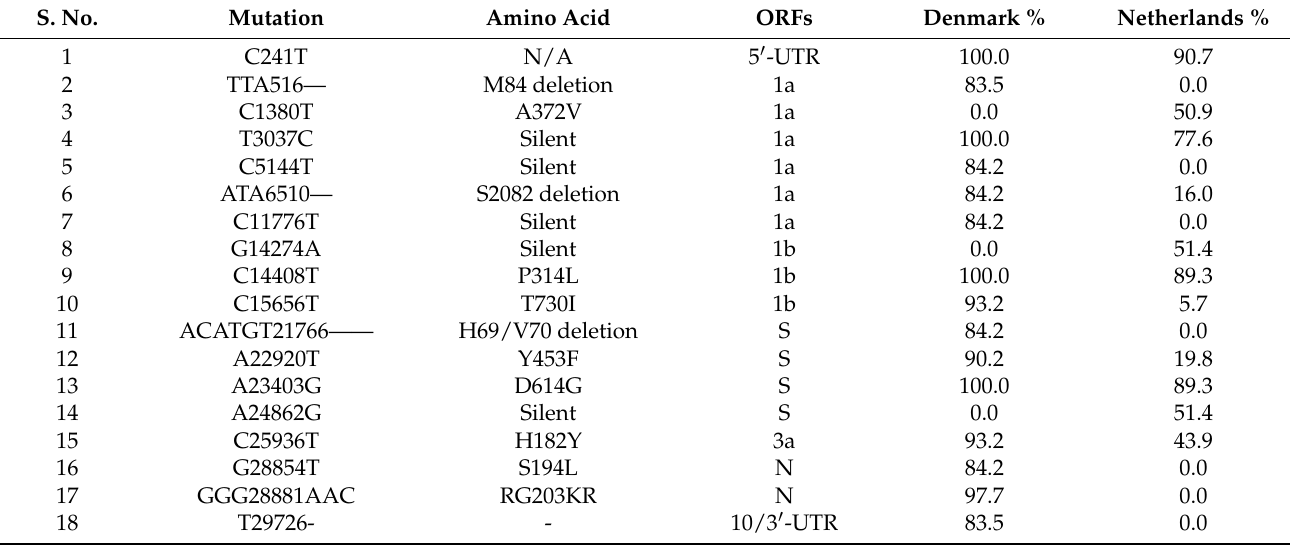
Table 2. Prevalent mutations in mink-derived SARS-CoV-2 genome.